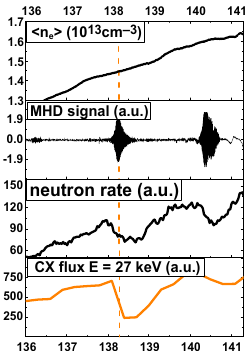
Figure 15. Correlation of neutron rate and CX flux with TAE bursts in discharge #31996. From top to bottom: line-averaged electron density, MHD signal, neutron rate, 27 keV atomic flux. The figure is taken from [45] and reproduced with permission from IOP Publishing.